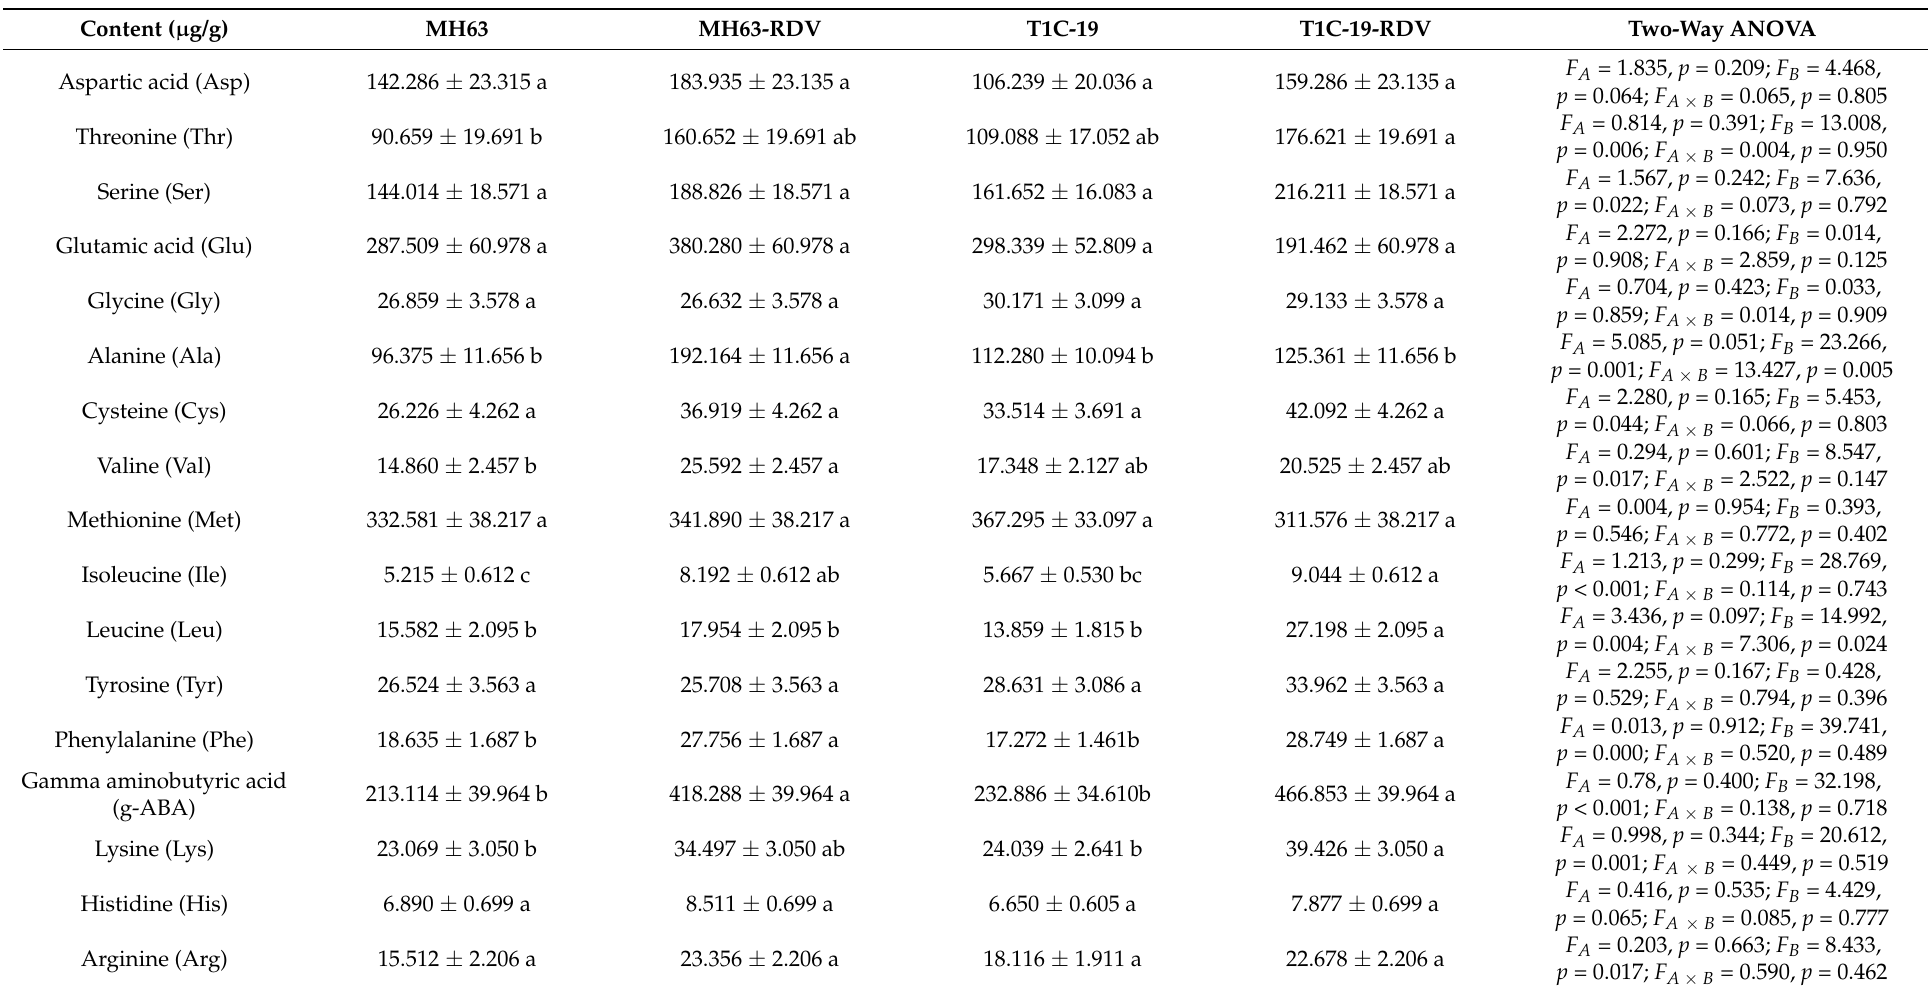
Table 1. Effects of rice type, RDV infection status, and the interaction of rice type and RDV infection status on free amino acid content in rice